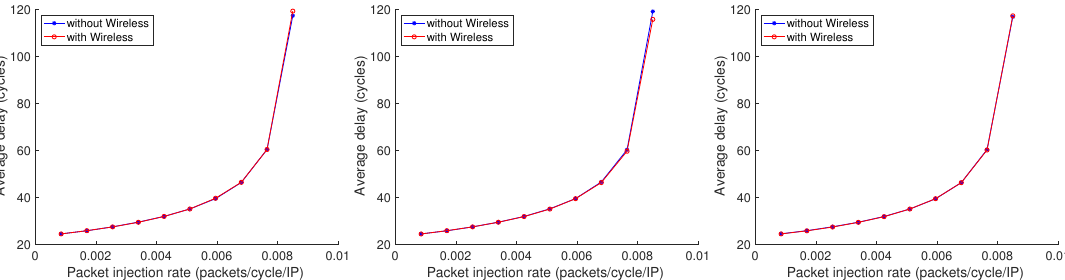
Figure 10. Average delay for profiles T 4 , T 8 , and T 16 for 256 Mesh topology and random traffic (TR-256 Mesh).